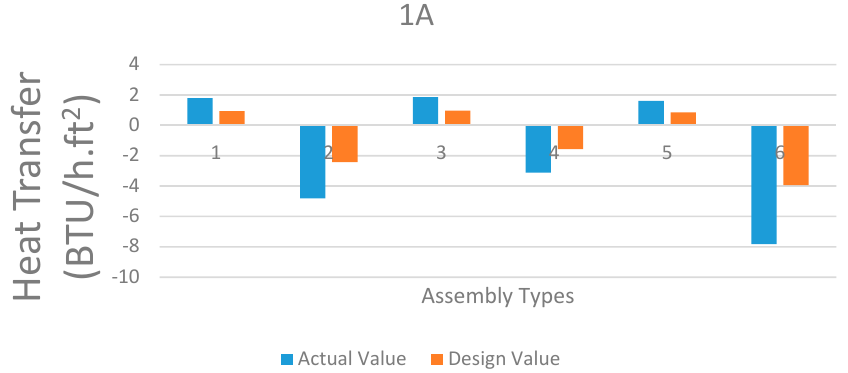
Figure 6. Heat losses in Assembly 1A (with series 1–6 representing the weather conditions as given in Table 8).